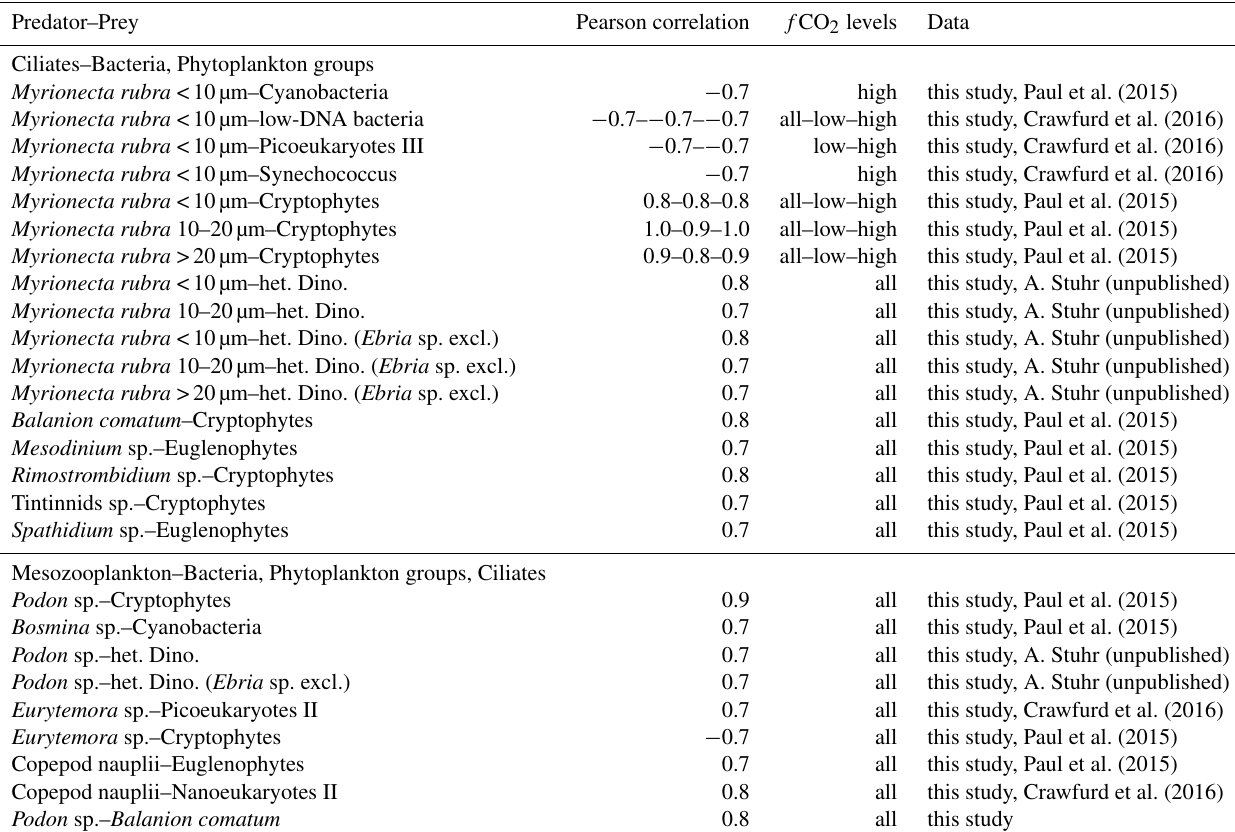
Table 2. Pearson correlation for various predator–prey relationships. Listed are only correlations (cid:62) 0.7. The pairwise correlation plots for all group combinations and the Pearson correlation coefficients can be seen from the supplemental material (Figs. S1–S2). het Dino.: het- erotrophic dinoflagellates, excl.: excluded. For Myrionecta rubra , Pearson correlation was determined combined for all f CO 2 levels and also separate for low (365, 368, 497µatm) and high (821, 1007, 1231µatm) f CO 2